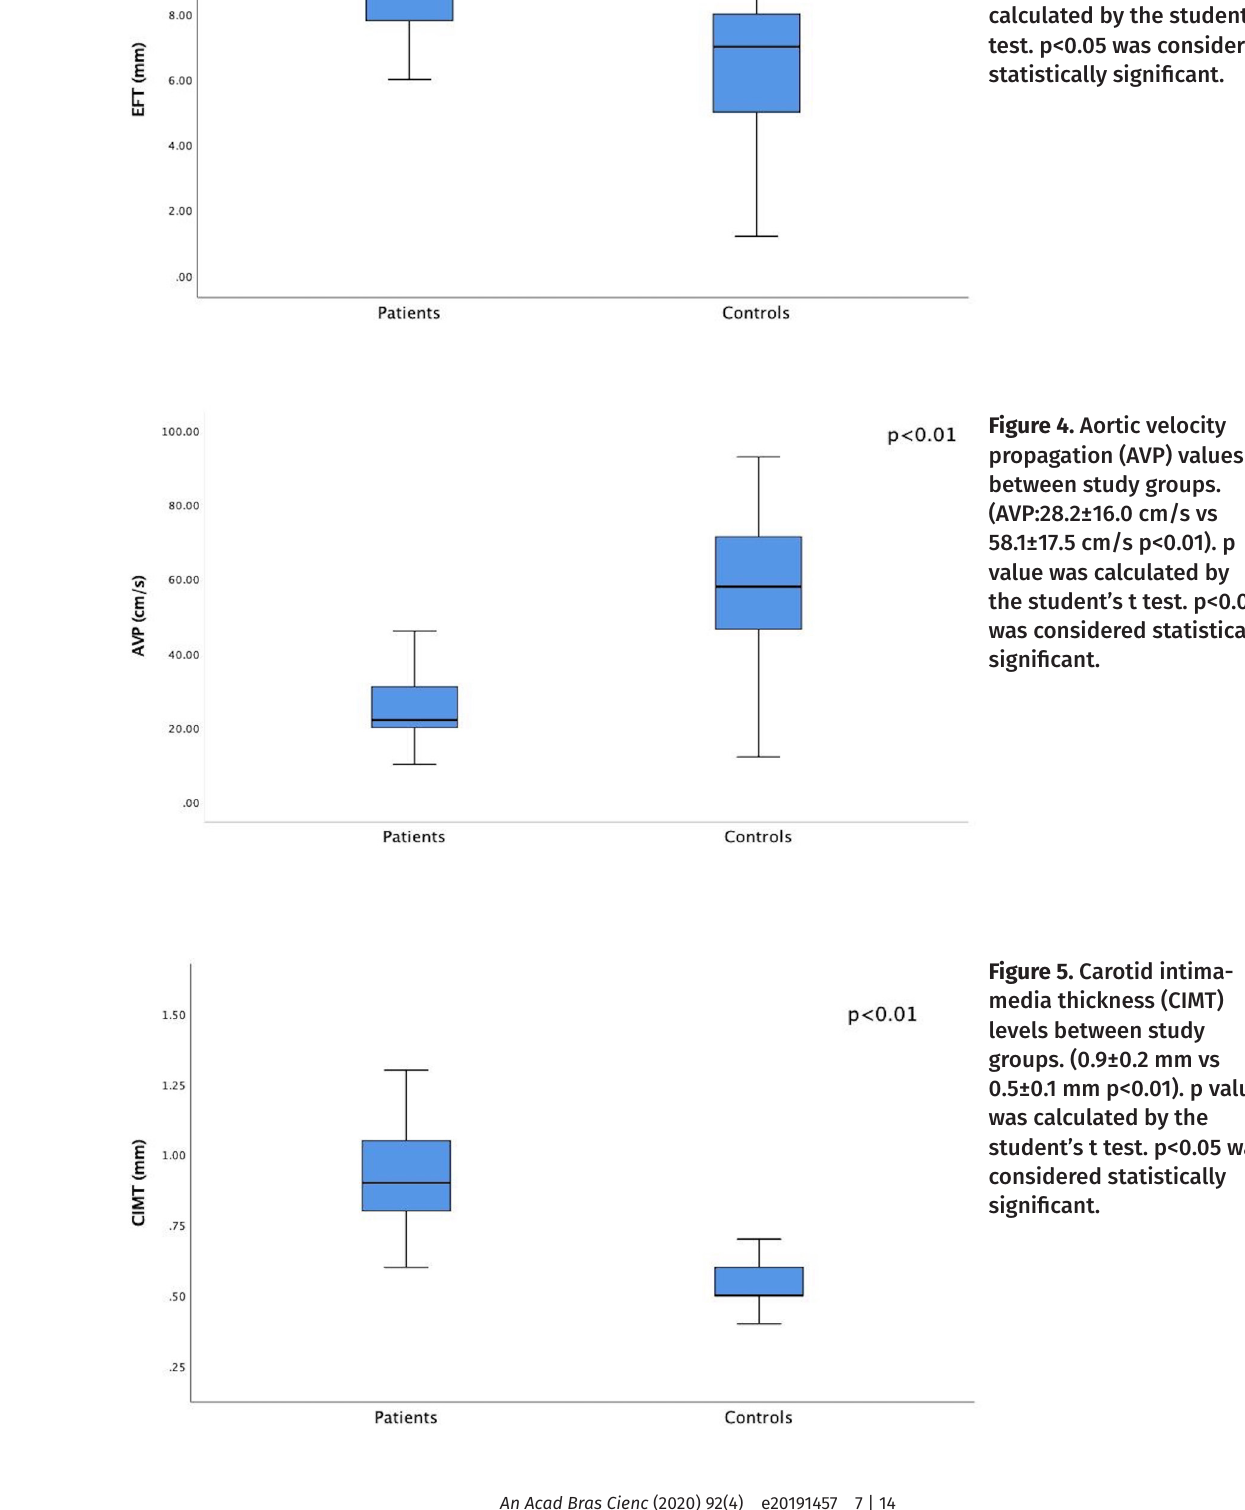
Figure 3. Epicardial fat thickness (EFT) values between study groups. (EFT:8.4±1.6 mm vs 6.3±2.2 mm p<0.01). p value was calculated by the student’s t test. p<0.05 was considered statistically significant.